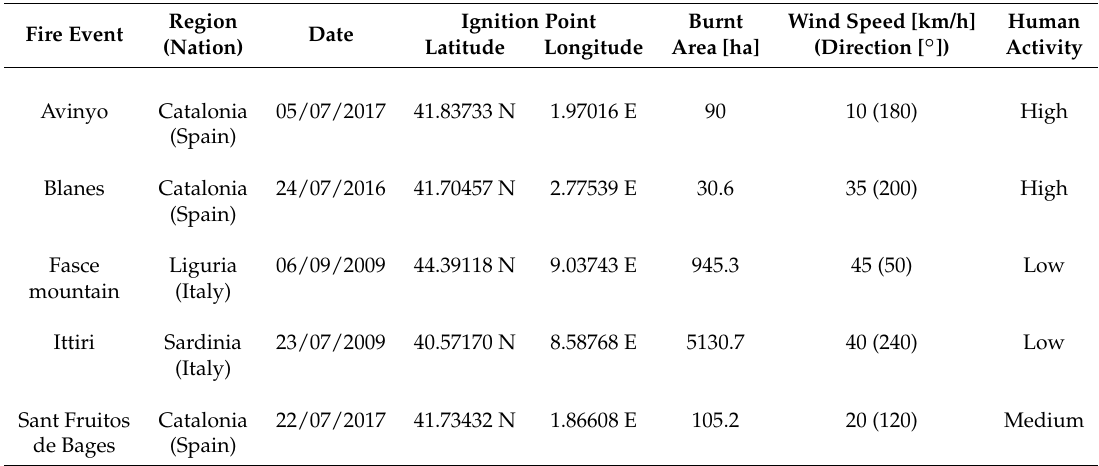
Table 2. Data of the case studies simulated in this work with PROPAGATOR